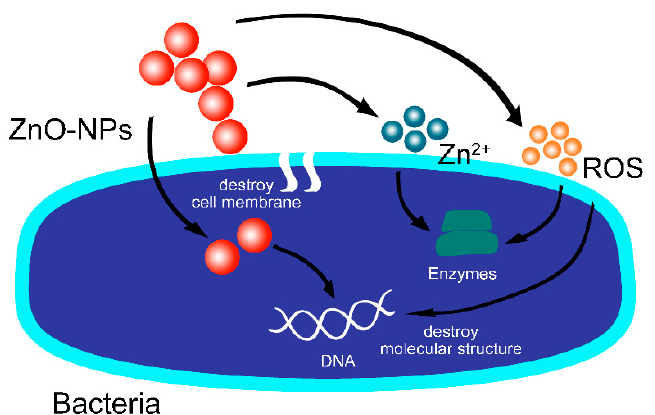
Figure 1. Antibacterial mechanism of ZnO-NPs. (ROS formation, Zn 2+ release, internalized ZnO-NPs, and electrostatic interactions.).